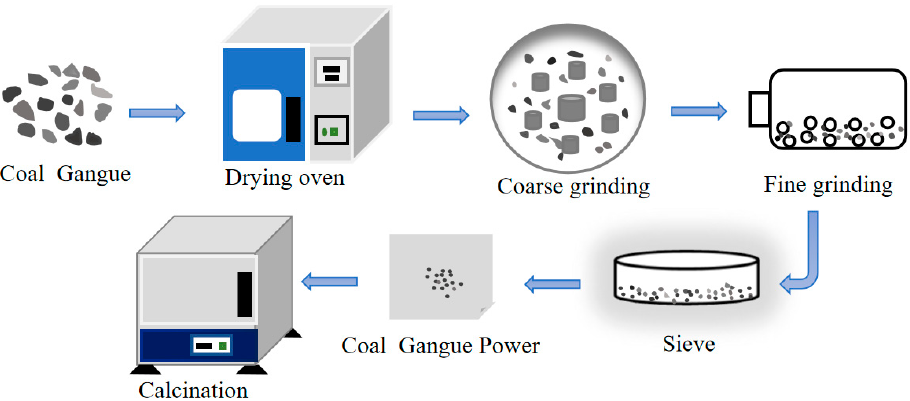
Figure 1. Preparation process of the thermally activated CG